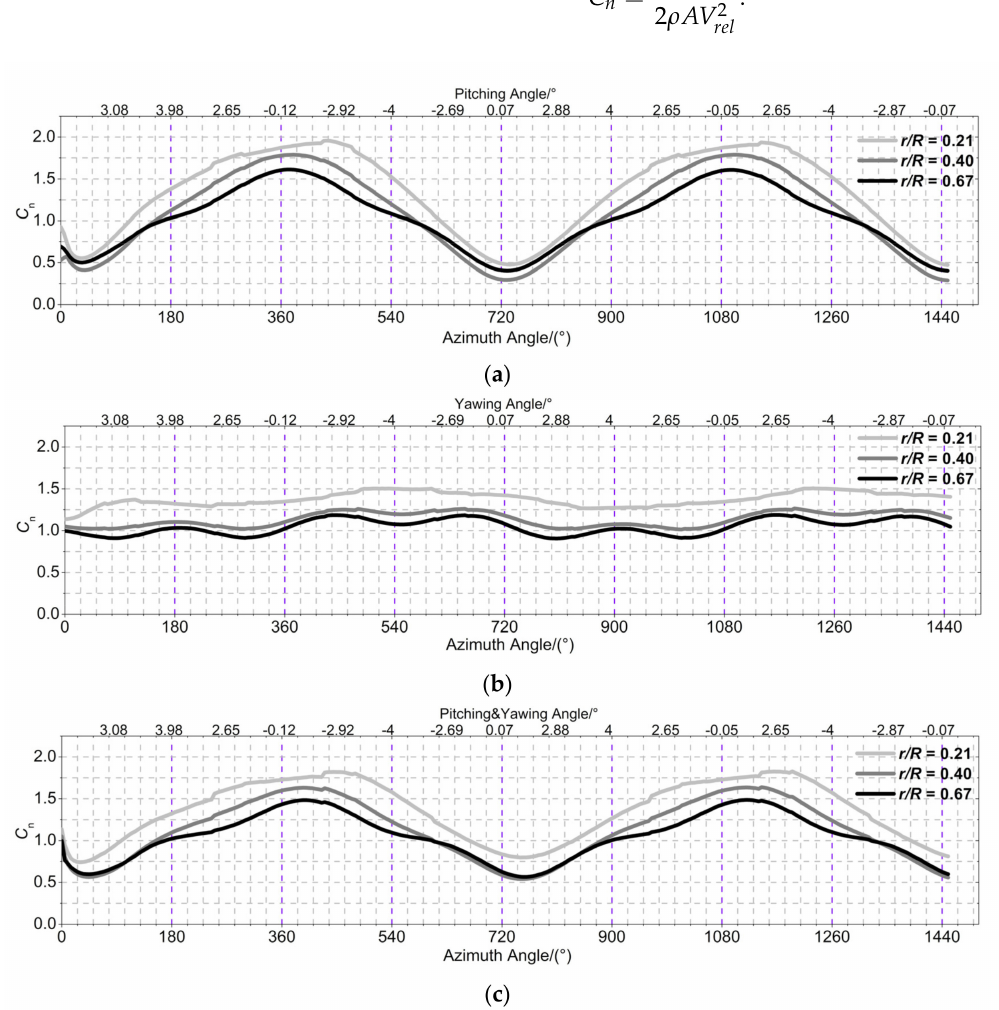
Figure 13. Variation in normal force coefficient at different spans for the platform motions. ( a ) pitch motion; ( b ) yaw motion; ( c ) coupled pitch–yaw